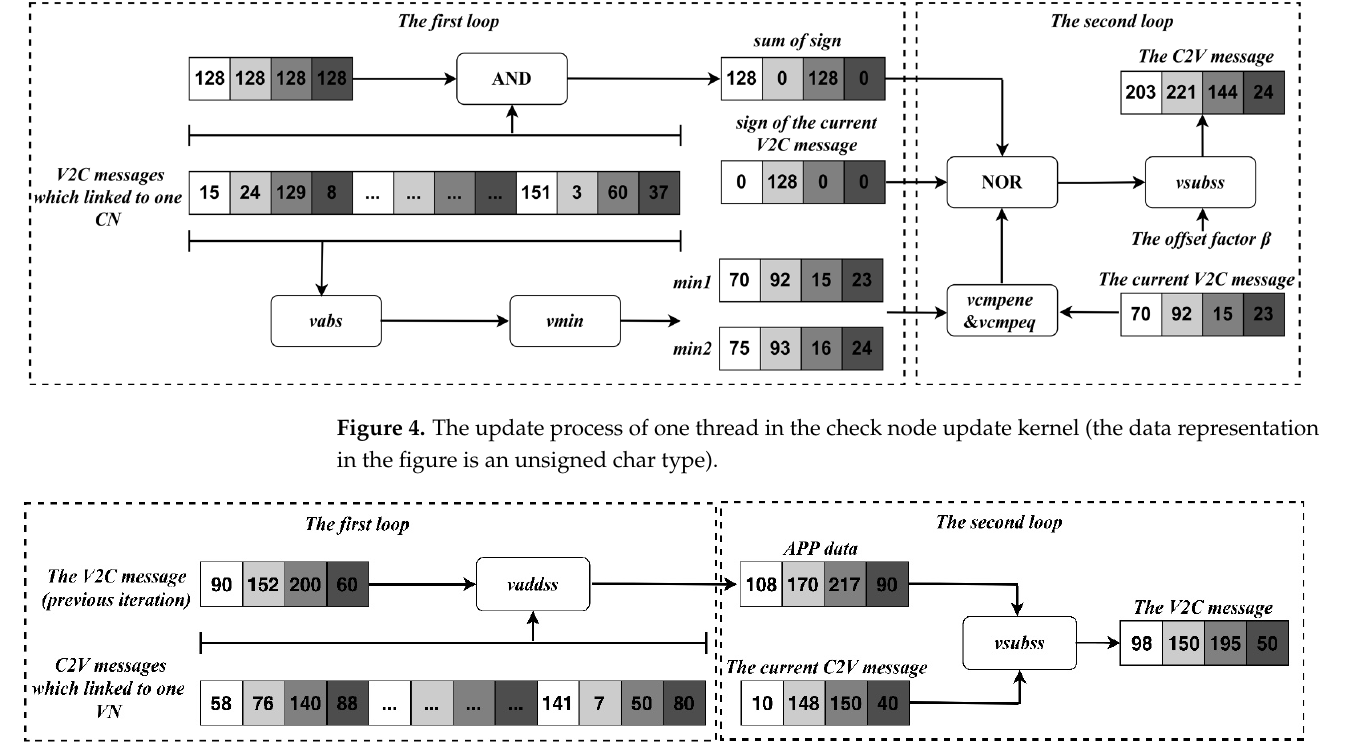
Figure 5. The update process of one thread in the variable node update kernel (the data representation in the figure is an unsigned char type).